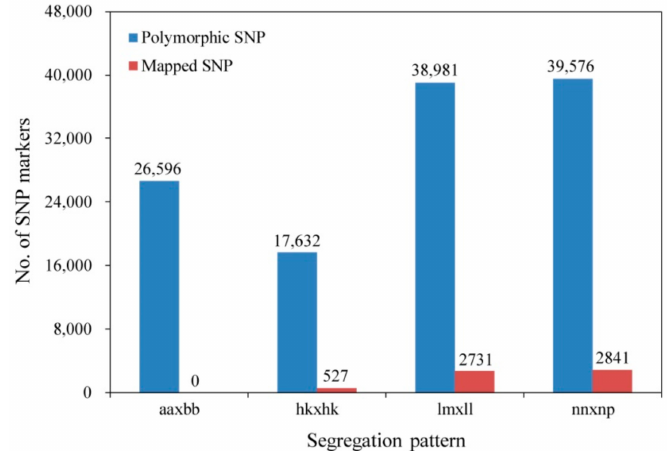
Figure 2. Number of polymorphic SNPs and final mapped SNPs in four segregation patterns.